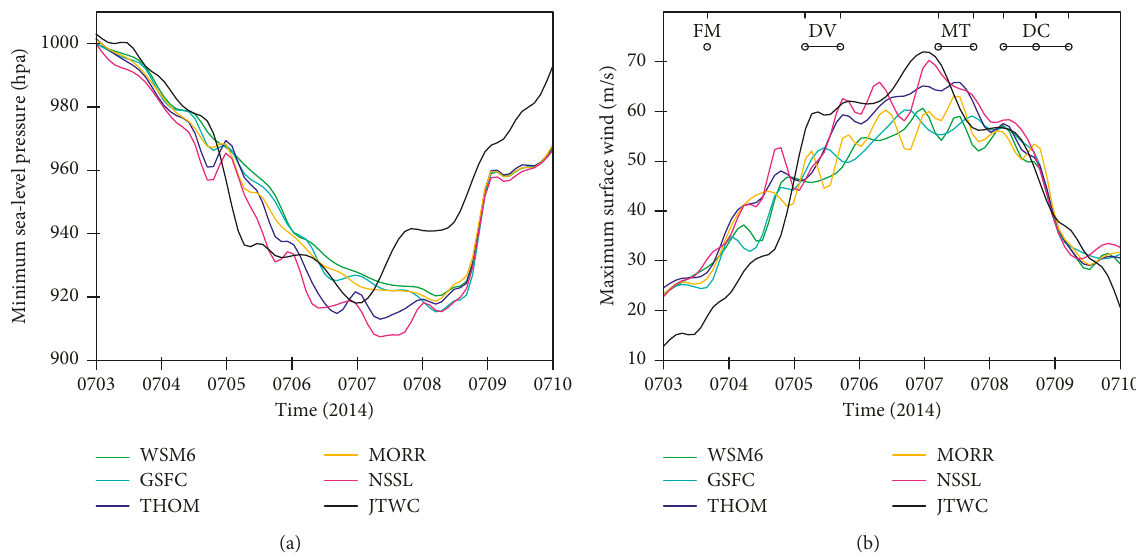
Figure 3: Comparisons of the intensity of typhoon Neoguri during 0000 UTC 3 July to 0000 UTC 10 July 2014 at 6h intervals: (a) minimum sea level pressure (MSLP) and (b) maximum surface wind speed (MWS), for the best track (JTWC) and the model simulations. The black solid lines indicate JTWC; the green curves, WSM6; the cyan curves, GSFC; the blue curves, THOM; the golden curves, MORR; and the pink curves, NSSL. At the top of panel (b), the times of the FY-3B observations are shown by short lines. The stages defined in this study (see text) are also shown at the top as FM (formation), DV (developing), MT (mature), and DC (decaying). The simulations began at 1200 UTC each day from 2 to 8 July 2014 and then integrated forward for 36hours, with 12-hour spin-up time.